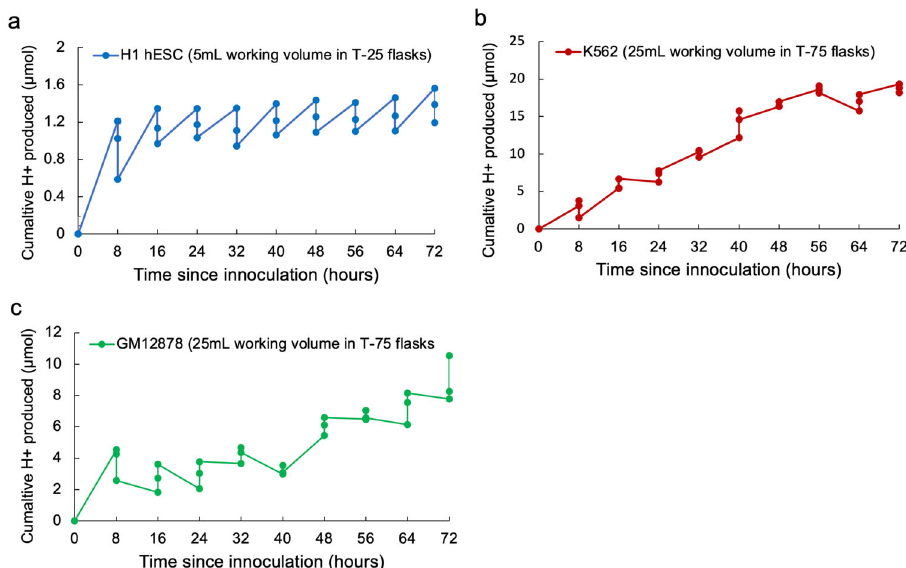
Fig. 3 Cumulative H + production in human cell cultures. Time course of cumulative H + production in the ( a ) H1 hESC, ( b ) K562, and ( c ) GM12878 cell lines, which were calculated using Eq. (1) (see Methods) following ref. 47 . The legend speci fi es differences in working volume and fl ask type among the cell lines. Measurements conducted for three culture fl asks per cell line (three biological replicates each). Data points at each time point represent data for the three biological replicates.